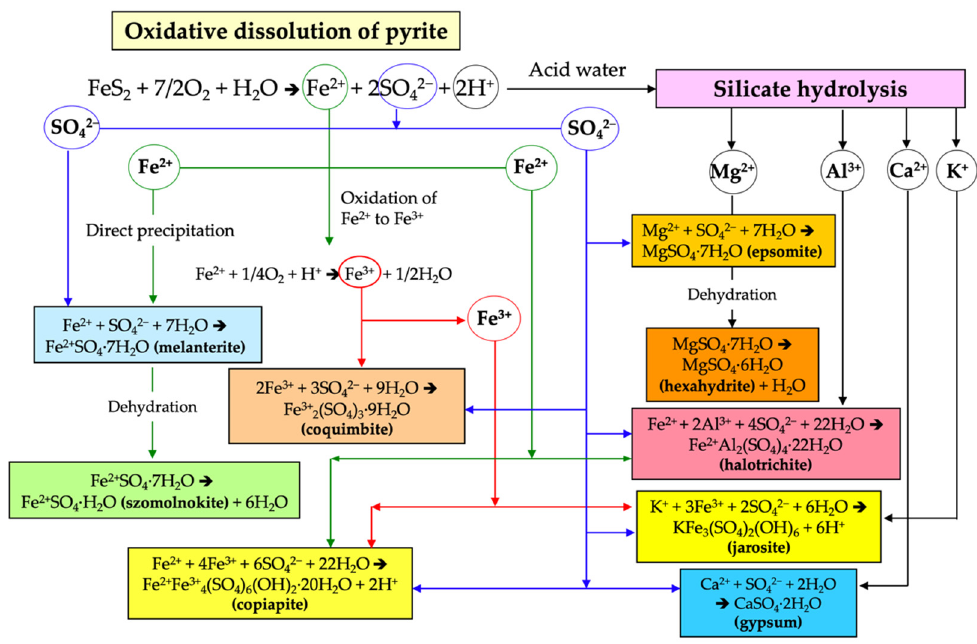
Figure 7. General flow chart of the chemical reactions involved in the formation of the secondary sulphate minerals.